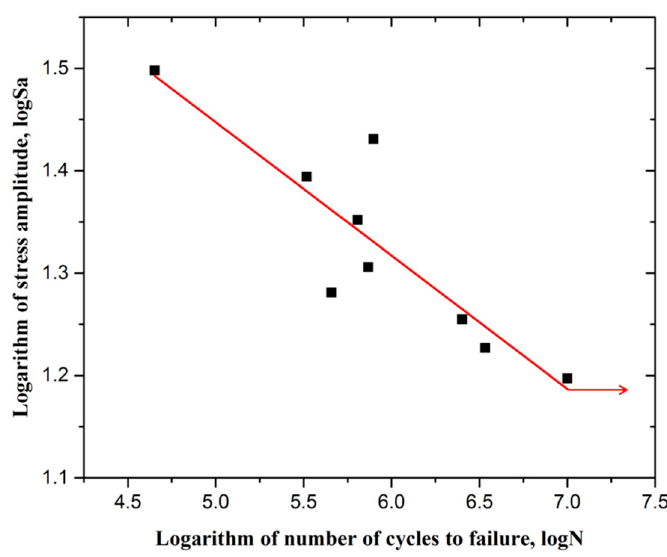
Figure 7. 6082 S–N curve of T-welded joint of aluminum alloy.